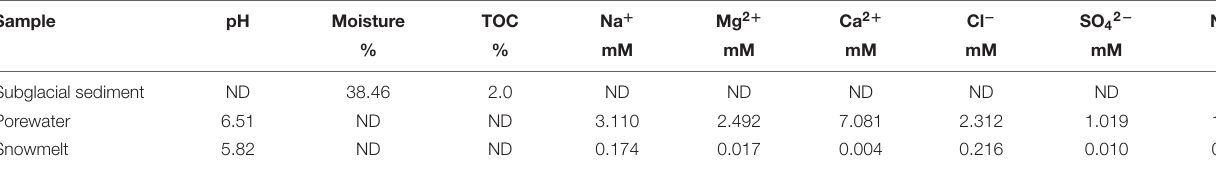
TABLE 1 | Geochemical characteristics of the samples in this